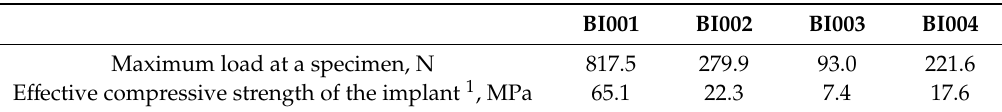
Table 4. Implants modeling parameters.